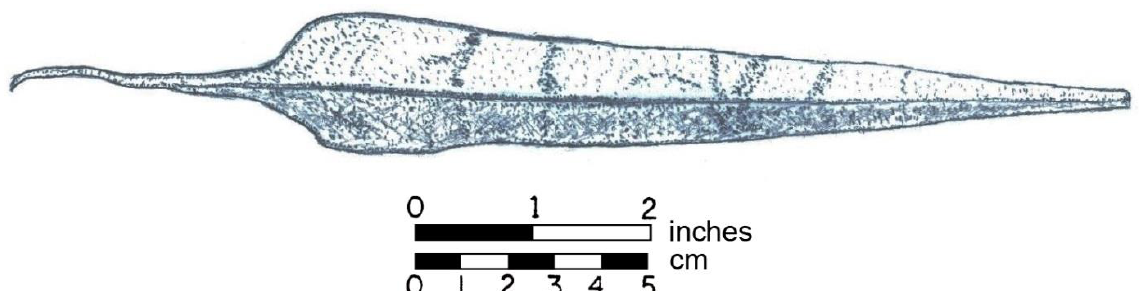
Figure 19. Field sketch of Old Copper Culture tanged or ‘rat-tail’ spear point found on the trail directly south of the Starman site where refined copper nuggets were also recovered (see Figure 3). Another almost identical spear point was found there in the 1930’s or earlier. The large size (approximately 30cm) indicates a purely ceremonial use. A number of other rat-tail and tanged-base Old Copper Culture spear points were found just to the east and south of the Starman site area (Steinbring et al 1995, Steinbring 1997).